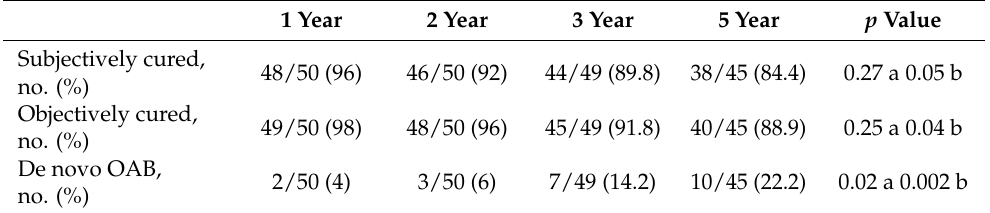
Table 2. Analysis of cure rates across the study period.